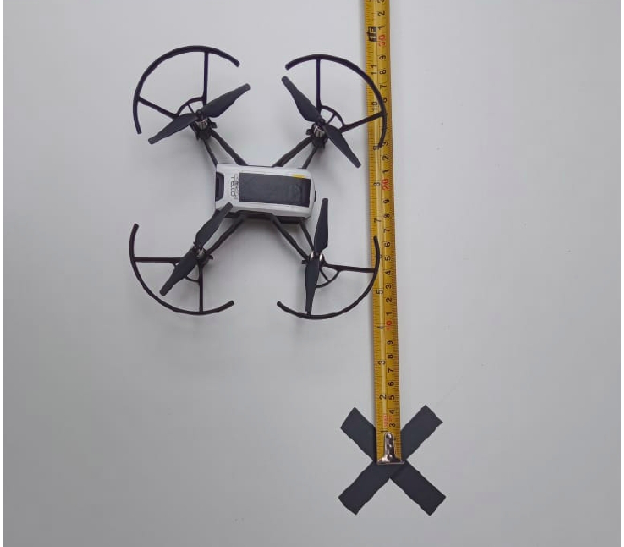
Figure 23. Manual position landing error measurement